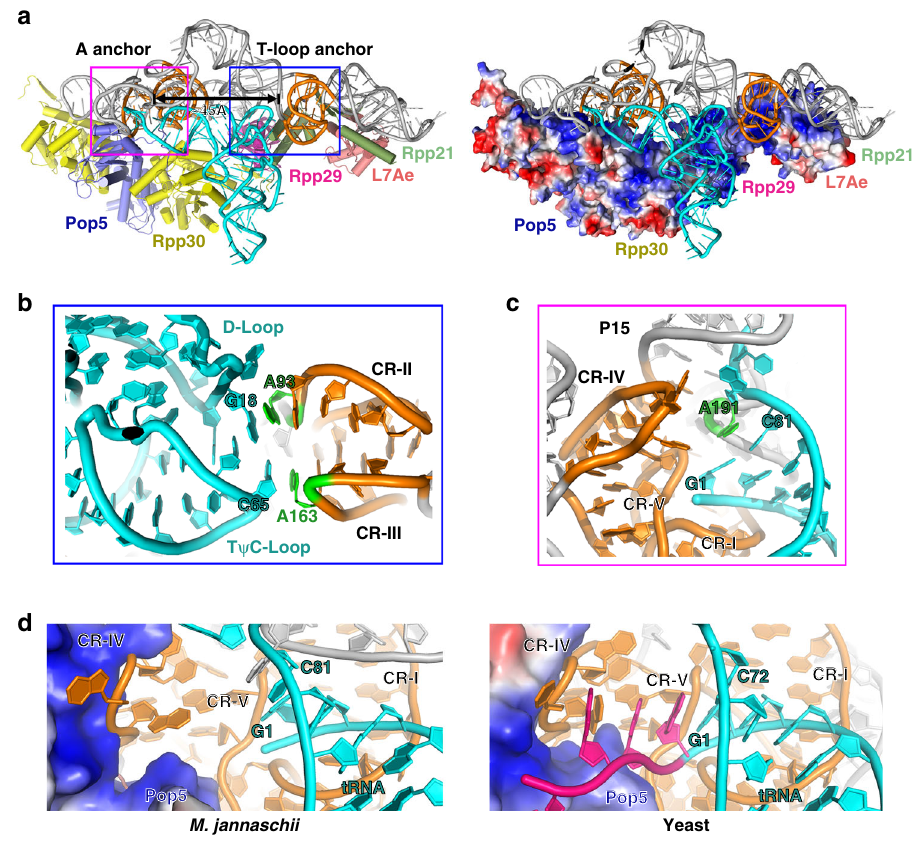
Fig. 6 tRNA recognition by Mja RNase P. a Overall structure of the monomeric Mja RNase P complex bound with tRNA. Protein components are shown in cartoon (left) and in electrostatic surface (right) representations, respectively. The magenta box denotes the A anchor and the blue box denotes the T-loop anchor. The distance between the two anchors is highlighted with a black double arrow. The tRNA is colored in cyan. b Close-up view of the T ψ C and D loops of tRNA that stack with the T-loop anchor in CR-II and CR-III of RPR. c Close-up view of the central nucleotide A191 (in green) in loop L 5 – 15 of RPR that stacks on the fi rst base-pair G1-C81 of tRNA. d Left panel: Close-up view of the active site in the Mja RNase P-tRNA complex. Right panel: Close-up views of the active site in the yeast RNase P-pre-tRNA complex (PDB: 6AH3). Pop5 is shown in surface representation and colored in electrostatic potential. RPR and tRNA are shown in cartoon and colored in orange and cyan, respectively. The 5 ′ leader of yeast pre-tRNA Phe is colored in